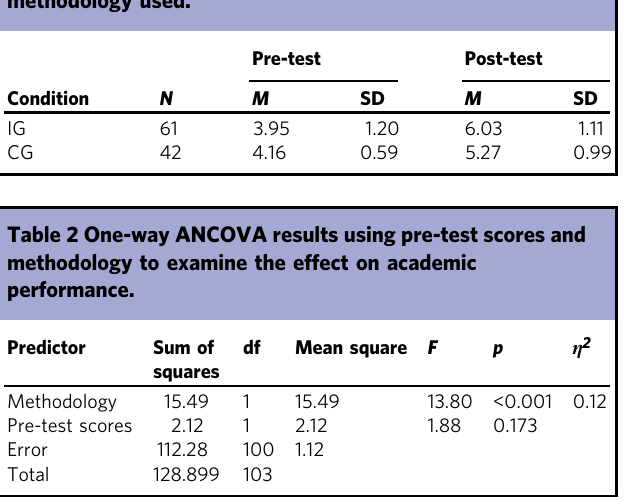
Table 1 Descriptive statistical data according to the methodology used.